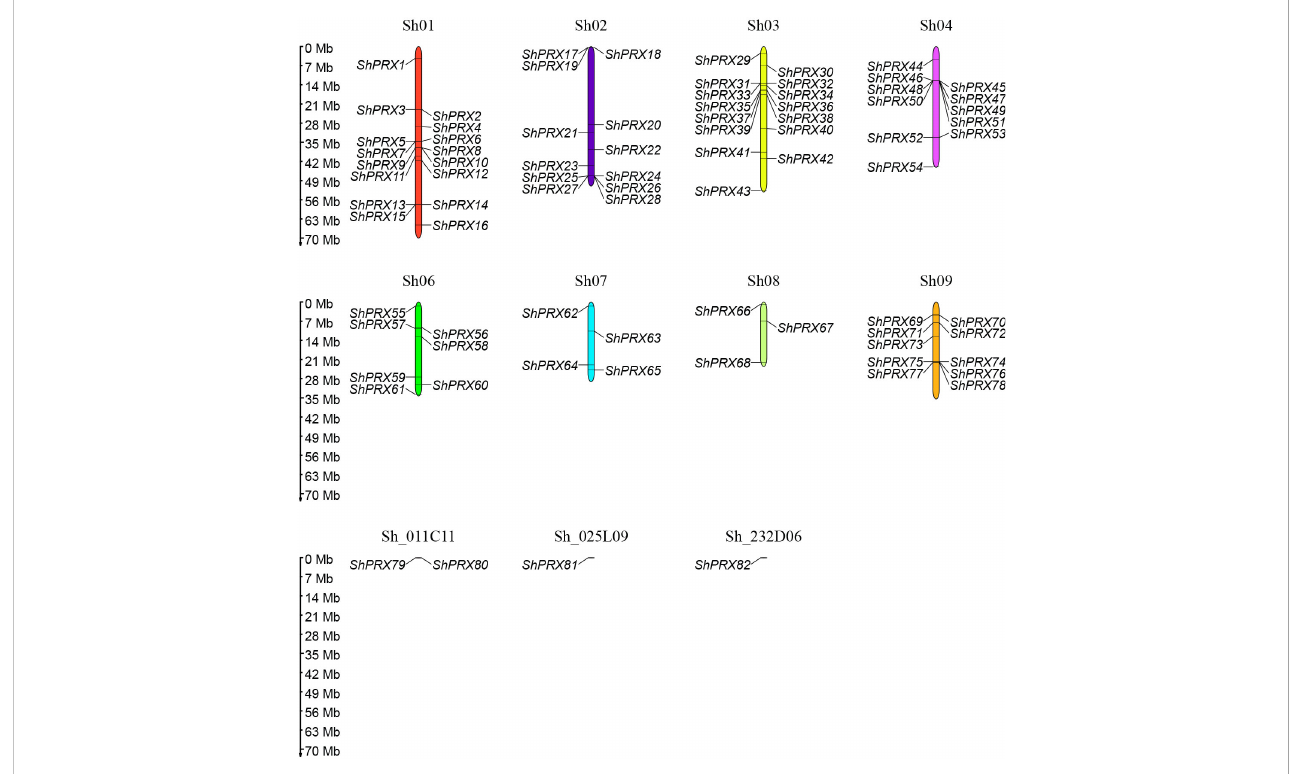
FIGURE 1 Distribution of the PRX gene family members on chromosomes in